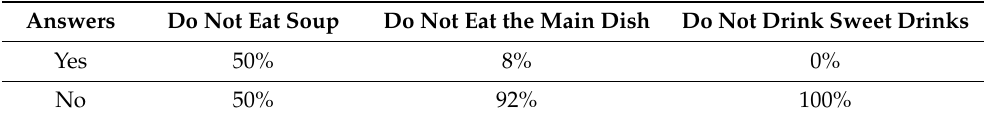
Table 5. Children’s food